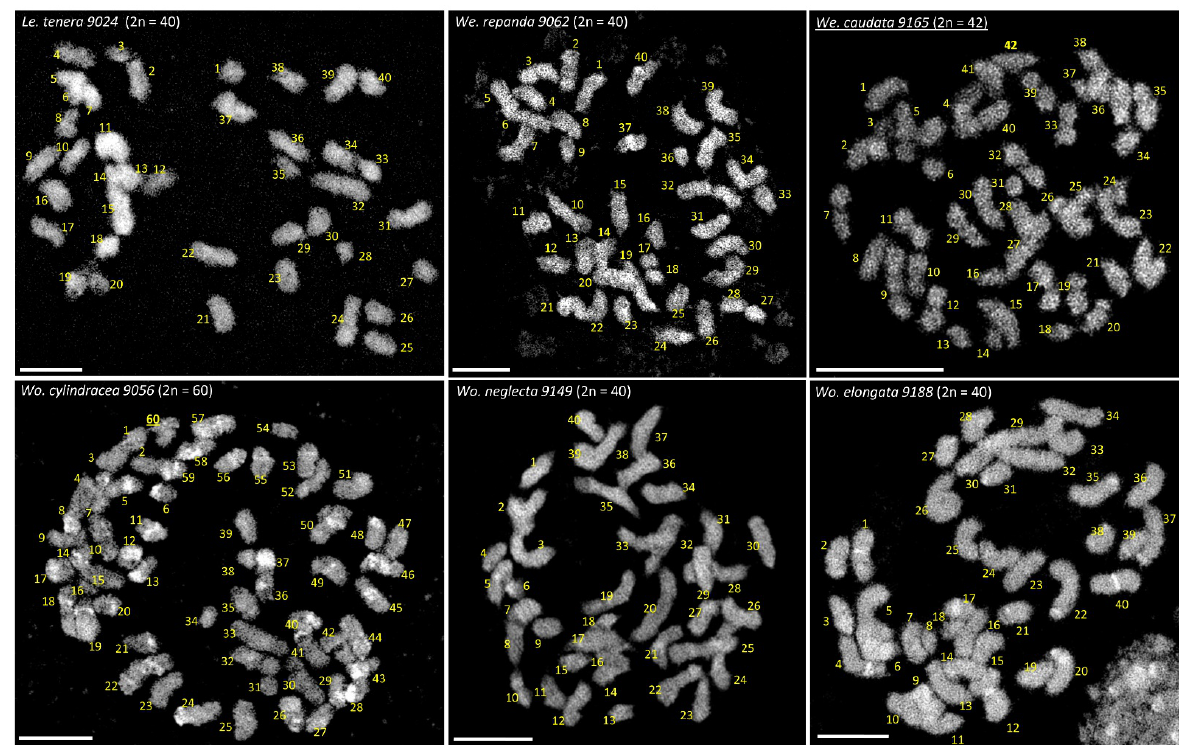
Figure 2. Metaphases with chromosome counts reported for the first time in this paper. To count clearly the chromosome number, image stacks from spatial super-resolution structured illumination microscopy (3D-SIM) [26] were used to identify overlapping chromosomes. Individual chromosomes were enumerated arbitrarily. Scale bar: 5 µm.